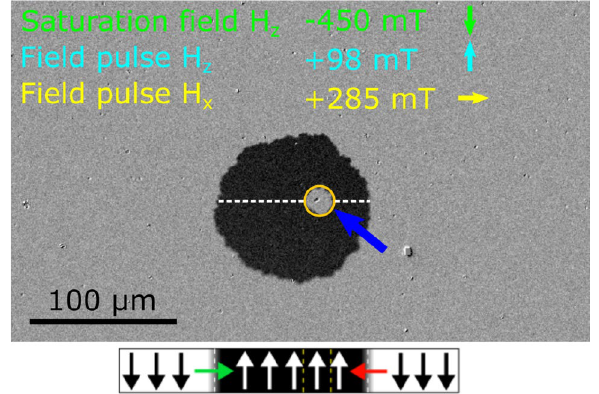
Figure 3. PMOKE difference image of the bubble domain growth with applied in-plane H x and out-of-plane H z fields for the buffer/NiO(10 nm)/Co(0.9 nm)/Pt(5 nm) system. The values and directions of applied fields are shown in the image. The yellow ring indicates the initial position of the initial bubble domain. Place below the image there is a scheme of the lateral magnetization profile along the dashed white line shown above. The N-DWs are marked by red and green arrows indicating anticlockwise chirality.